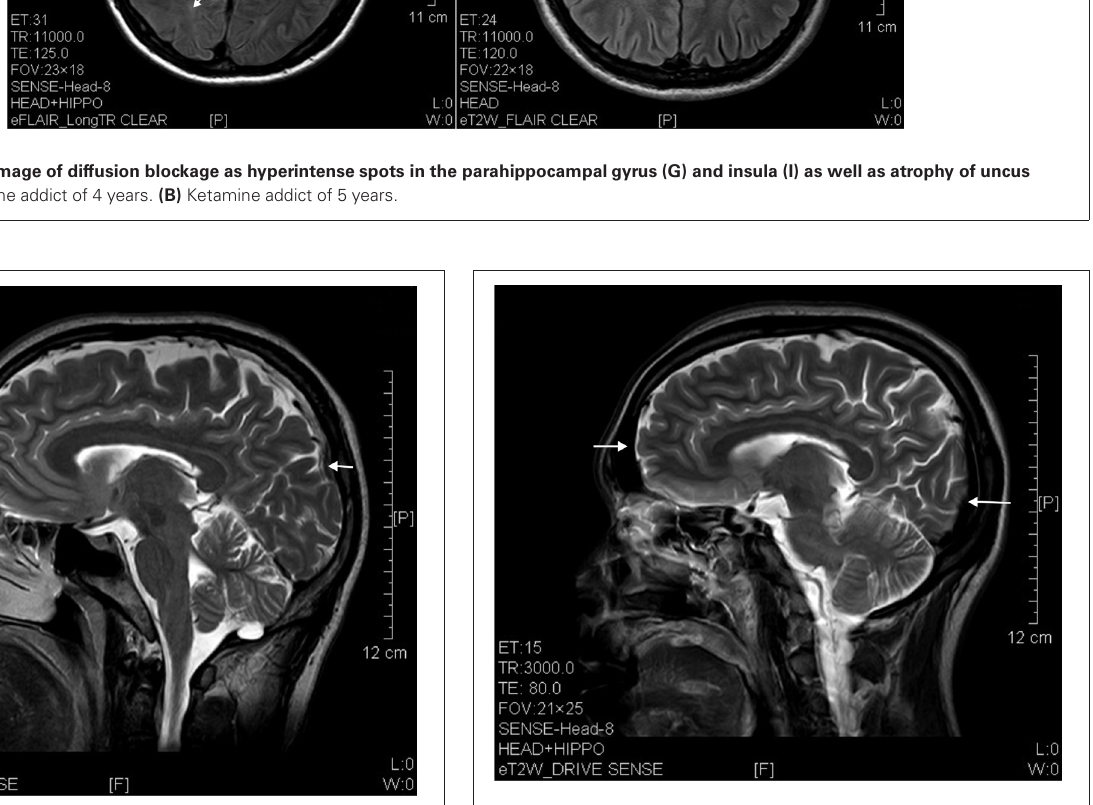
FIGURE 4 | T2 image showed parietal atrophy (arrow) in a sagittal brain section of a ketamine addict of 4 years.